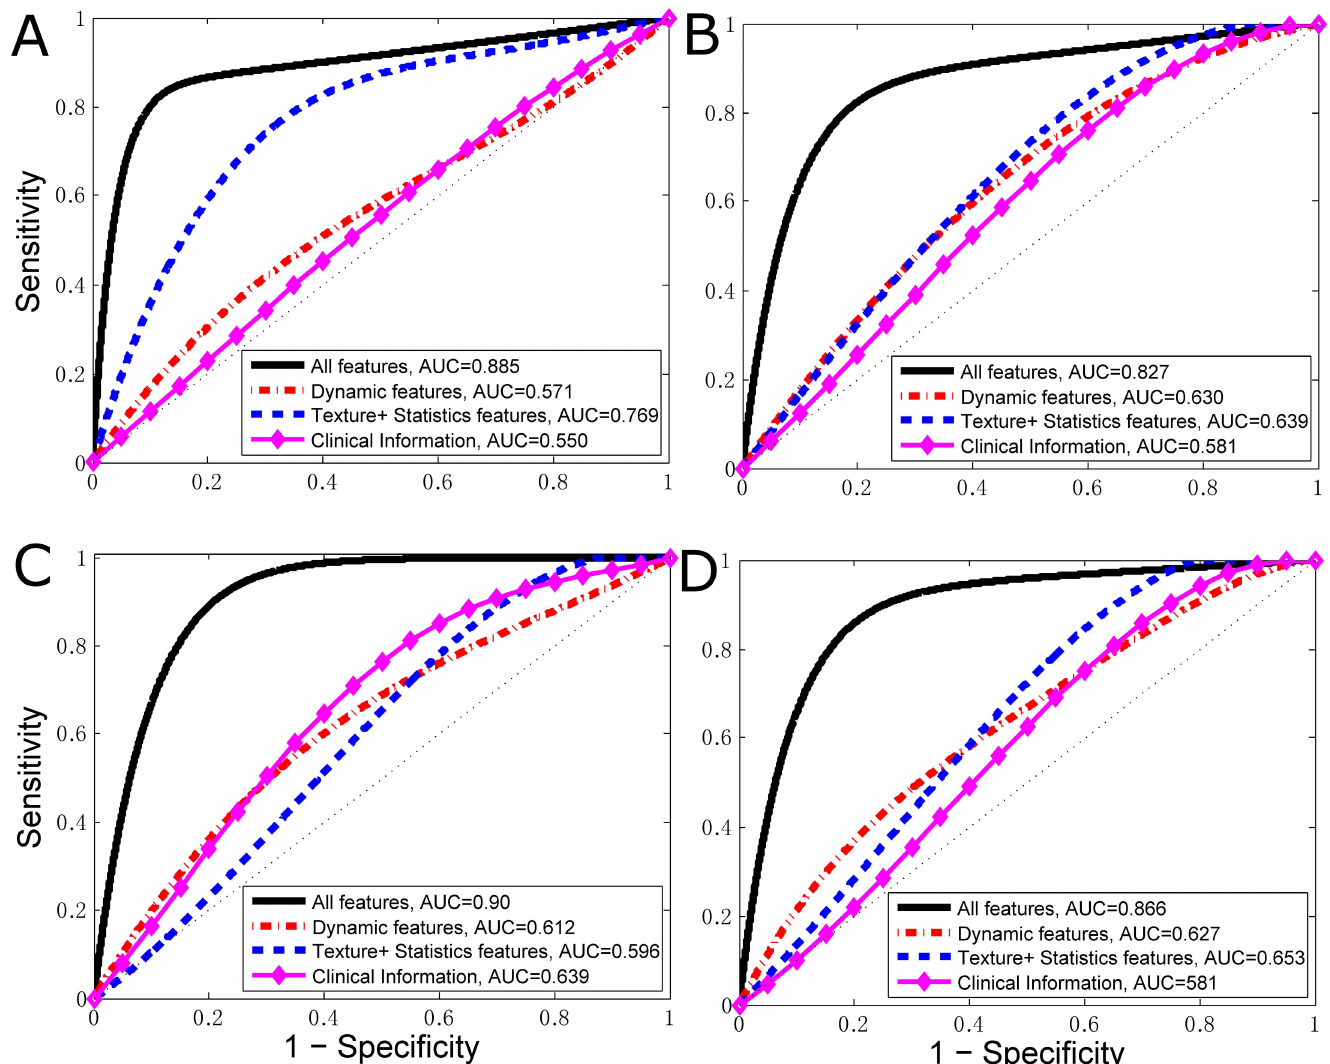
Fig 3. ROC curve in the first cohort for classifying the four molecular subtypes of breast cancer. The classifiers based on dynamicfeatures, morphologic features, first-order statistical features and clinical information are shown. Features are combinedto classify between(a) luminalA and non- luminalA tumors; (b) luminalB and non-luminalB tumors; (c) HER2-positive and non-HER2-positive tumors; and (d) basal-like and non-basal-like tumors.